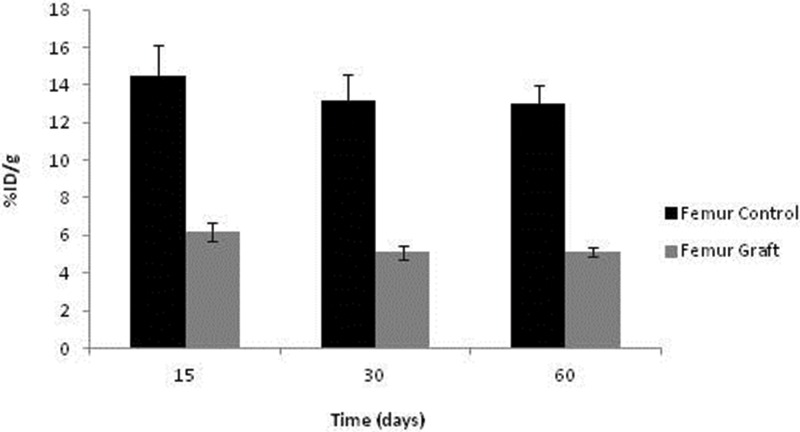
Uptake of 99mTc-MDP in the femur.